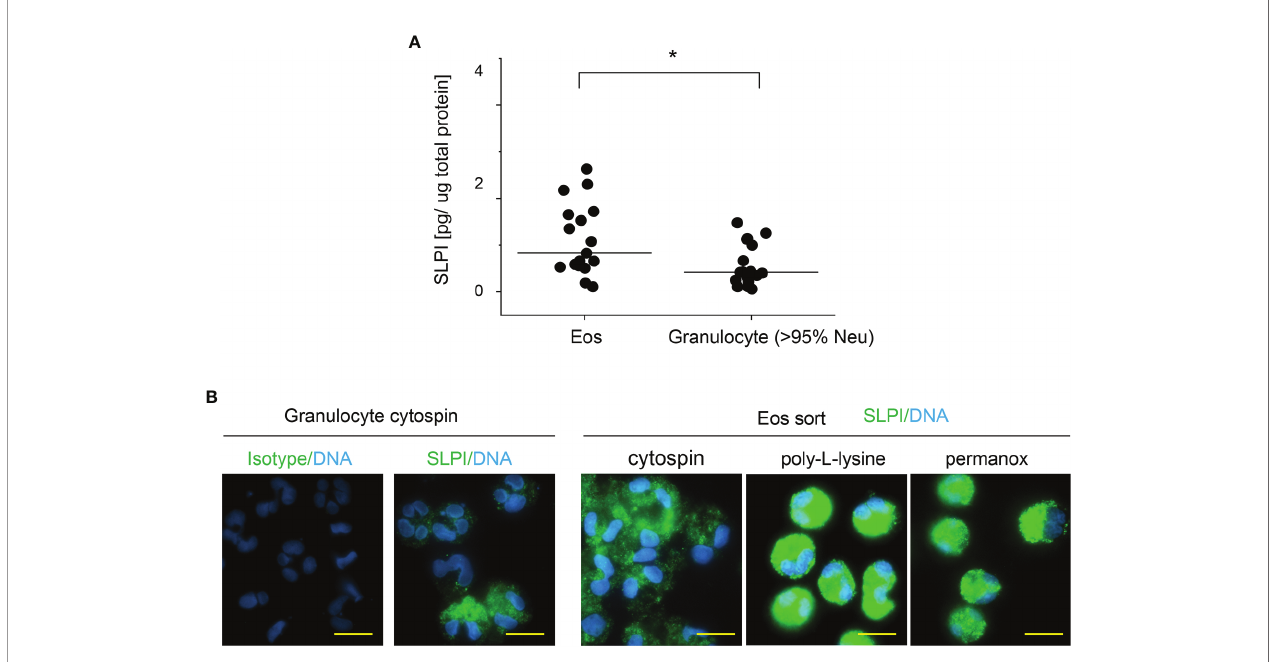
FIGURE 3 | Eosinophils have higher SLPI protein levels compared to neutrophils, but their immunoreactivity for SLPI varies with experimental conditions. Granulocytes and eosinophils were isolated from the blood of healthy donors. (A) The cells indicated were subjected to cell lysis followed by SLPI-speci fi c ELISA. Data are normalized to total protein levels determined by BCA. Dots indicate individual donors and lines the median value for each data set. n = 17, *p < 0.05; Mann – Whitney test. (B) The cells were directly deposited onto microscope slides via centrifugation (cytospin) or were fi rst incubated on poly-L-lysine-covered slides for 20 min followed by short cytospin (poly-L-lysine) or were incubated on Permanox slides for 20 min (Permanox). The cells were then stained using biotinylated mouse anti-human SLPI mAbs or isotype control mAbs followed by PE-labeled streptavidin. Data are from one donor and are representative of at least 2 donors. Scale bar = 10 m